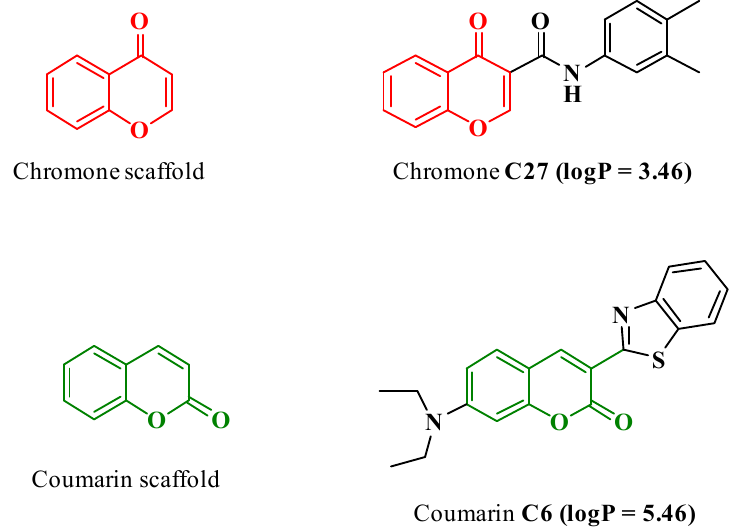
Figure 1. Chemical structures of chromone C27 and coumarin C6. The values of logP were obtained from the literature [5,9].